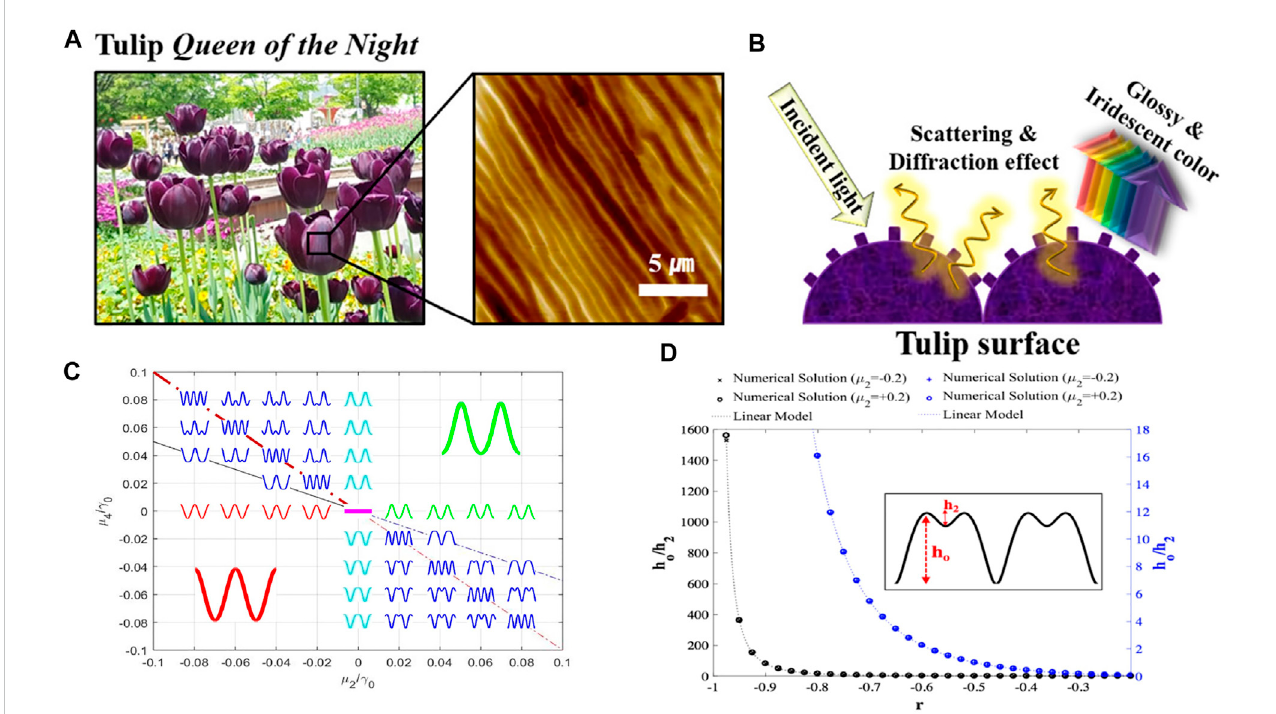
FIGURE 2 Biological cylindrical (corrugation with a single wave-vector) wrinkling patterns and the simulation results. (A) AFM image of Queen of the Night tulip petals. (B) Theopticaleffectsonthesurfaceoftulippetals. (C) Dimensionlessparametricanchoring μ 4* − μ 2* spaceandcharacteristicwrinklingpro fi les,where the pink line in the centre represents a fl at surface. (D) Representative two scale wrinkling and de fi nition of large ( h 0 ) and small ( h 2 ) wrinkling scales. In (C) we observe: (I) up-down symmetry between second and fourth quadrants and between fi rst and third quadrants and (ii) the maximal two scale wrinkling appears below and above the diagonal line (red dash-dot line) crossing the 2 – 4th quadrants. (A) and (B) are reprinted with permission from (Oh et al., 2019). Copyright ⓒ 2019, American Chemical Society. (C) and (D) are reproduced from (Rofouie et al., 2018) with permission from the Royal Society of Chemistry.